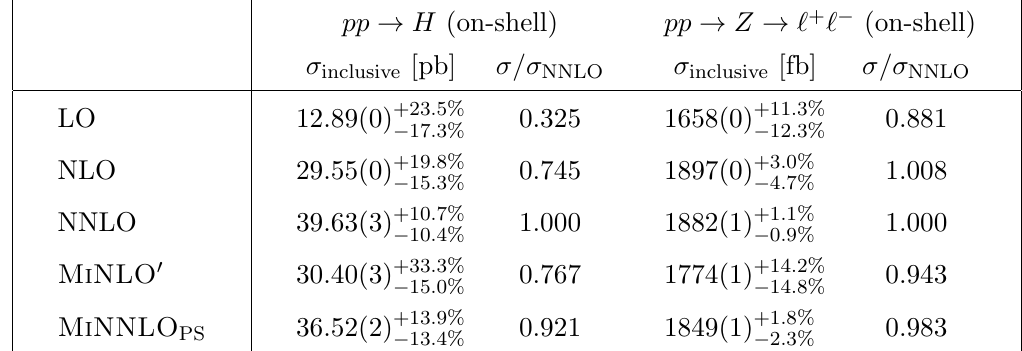
Predictions of the total inclusive cross section for Higgs-boson production and the DY process at the LO, NLO, and NNLO, as well as using the MiNLO 0 and MiNNLO PS calculations. For comparison also a column with the ratio to the NNLO cross section is